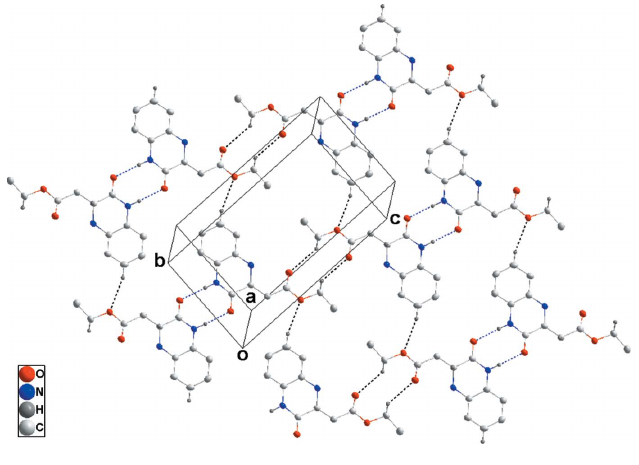
Figure 2 Plan view of a portion of one layer with N—H (cid:2)(cid:2)(cid:2) O and C—H (cid:2)(cid:2)(cid:2) O hydrogen bonds shown, respectively, by blue and black dashed lines.